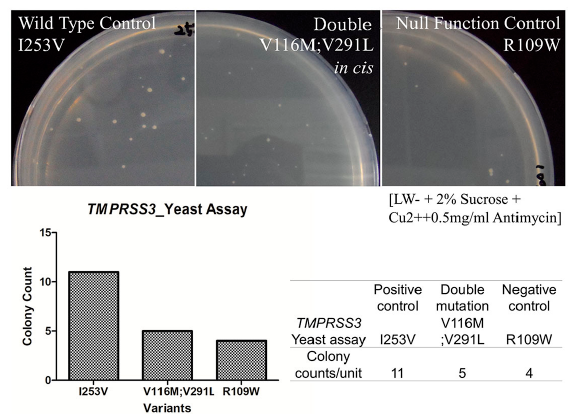
Figure 3. Assay for the proteolytic activity of the transformants of each genotype of TMPRSS3 . Colonies were counted with the criteria in a well-shaped order. Far left panel indicates the wild type controls; right indicates null function controls. Compared with these, the middle one contains the proteolytic activity of double mutated constructs: the double mutants, p.V116M and p.V291L, show a significantly weaker proteolytic activity than the one on the left, suggesting pathogenicity. (A medium containing Leu − /Trp − + 2% Sucrose + Cu 2+ + 0.5 mg/mL Antimycin).